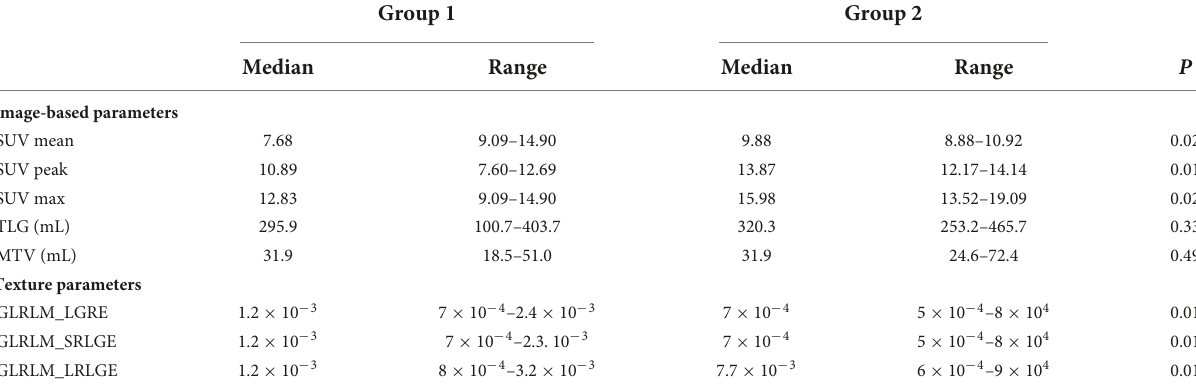
TABLE 2 Results of independent-samples Mann–Whitney test analysis parameters 18F-FDG PET/CT for cervical cancer predicting overall survival. Group 1 Group 2 Median Range Median Range P